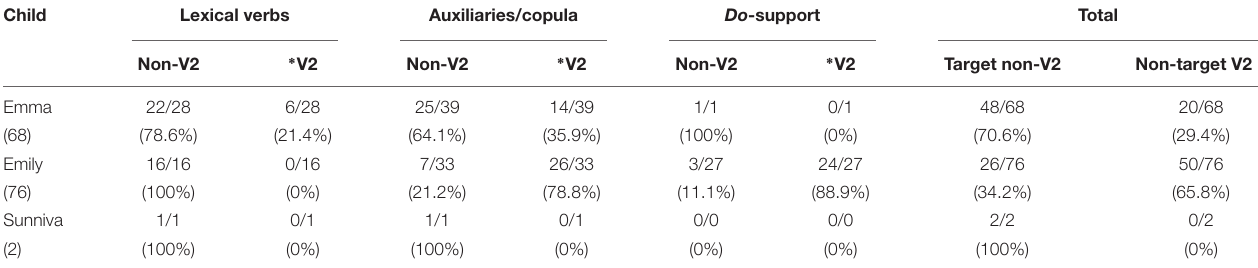
TABLE 7 | Finite verb placement in topicalised constructions, divided into verb types, in Emma, Emily and Sunniva’s files. Child Lexical verbs